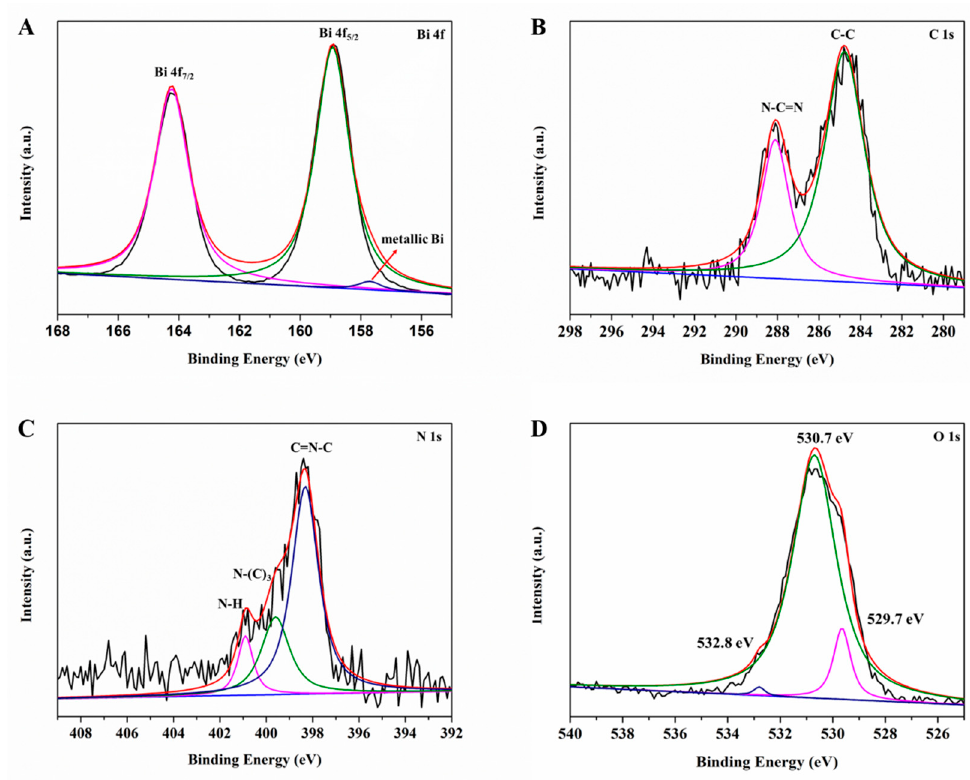
Figure 4. XPS spectra: ( A ) Bi 4f, ( B ) C 1s, ( C ) N 1s and ( D ) O 1s of BOC-CN-Bi composites. The UV-vis diffuse reflectance spectra are acquired to assess the optical response range of all samples. Pristine BOC and CN reveal severally conspicuous absorption edges at approximately 400 and 500 nm (Figure 5A). The absorption edges for BOC-Bi and CN-Bi possess a slight redshift compared to pristine BOC and CN, which suggests that metal Bi could slightly ameliorate the visible light absorption capacity of photocatalysts [36,37]. Intriguingly, BOC-CN-Bi ternary photocatalysts have a wider visible light absorption range than BOC and BOC-Bi, insinuating the likelihood of better photocatalytic performance for BOC-CN-Bi ternary photocatalysts. The wider visible light absorption range assures that BOC-CN-Bi could provoke ample photoinduced e − -h + pairs. As presented in Figure 5B, the band gap of pristine BOC and CN are estimated as 3.17 and 2.38 eV via the Kubelka-Munk formula. Furthermore, the band gap of all composites is shown in Figure S1. The band gap for BOC-CN-Bi is 2.6 eV. Compared with BOC, the BOC-CN-Bi composite has a narrower band gap and higher carrier separation for efficient photocatalytic hydrogen production.